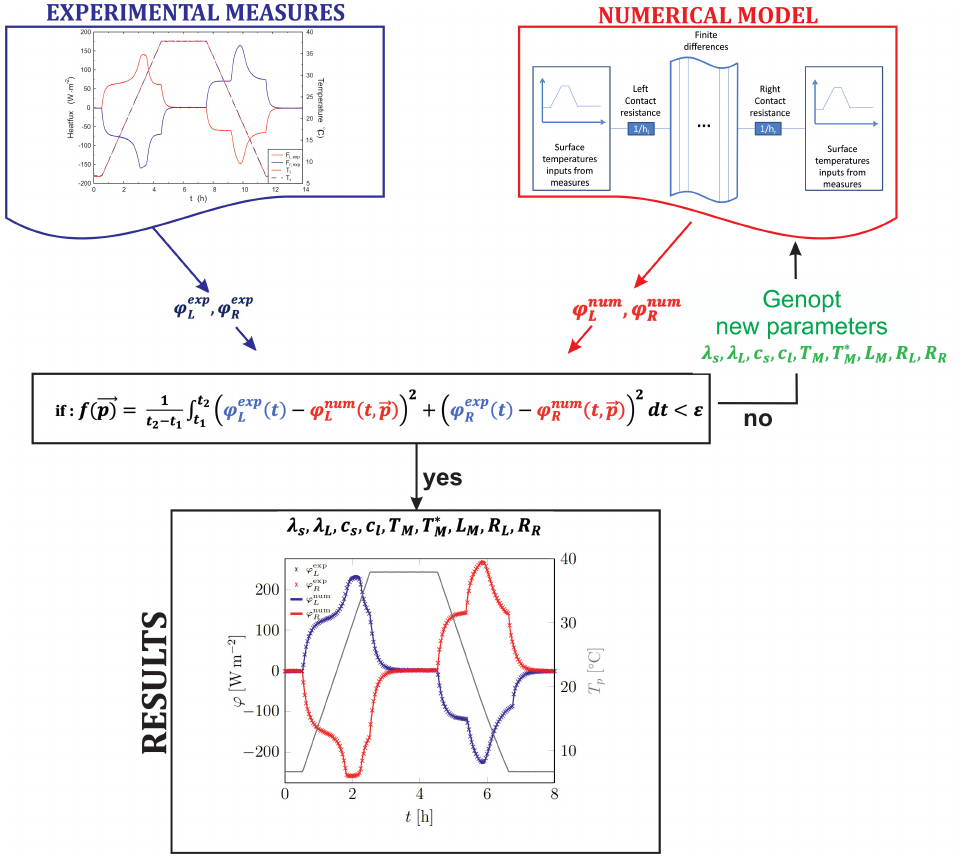
Figure 1. Graphical abstract of the present method. Table 1. Densities for all the involved materials.